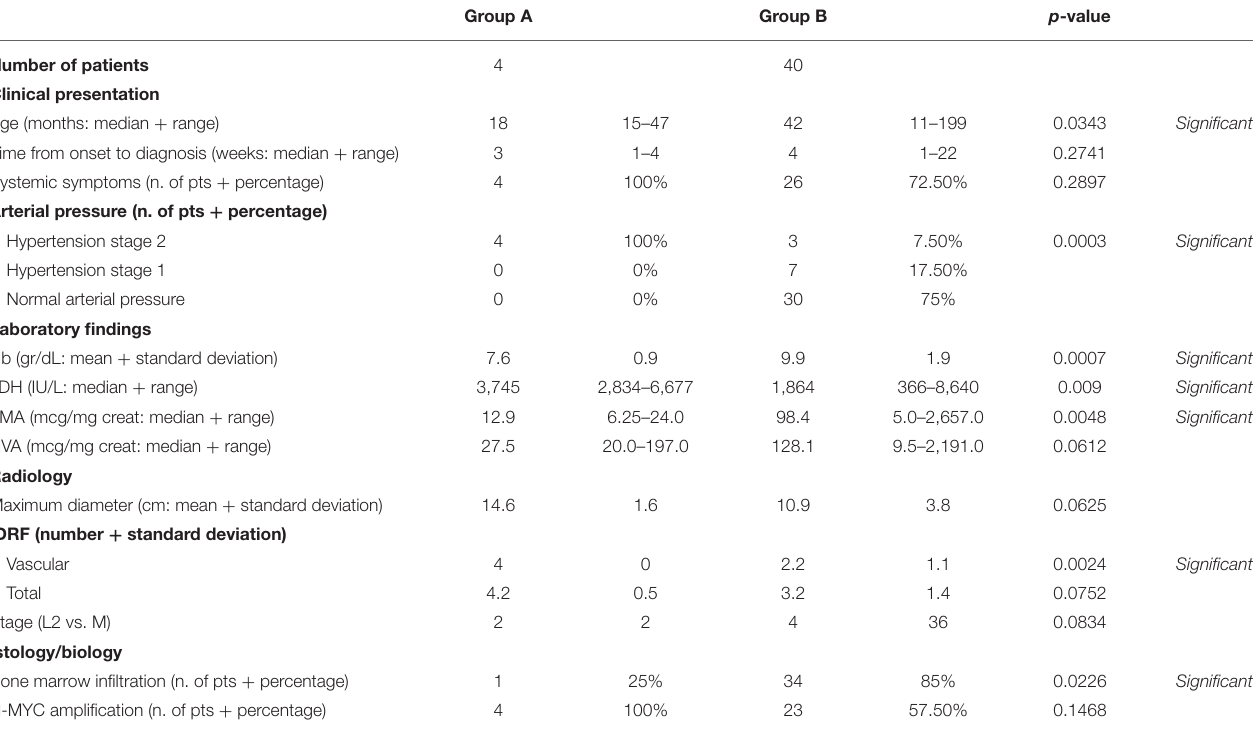
TABLE 4 | Comparison and statistics.